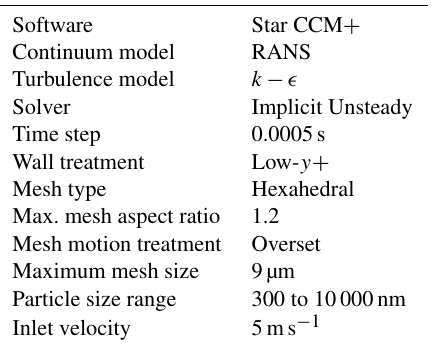
Table 1. Details of the model set-up for the CFD–LPT simulations.